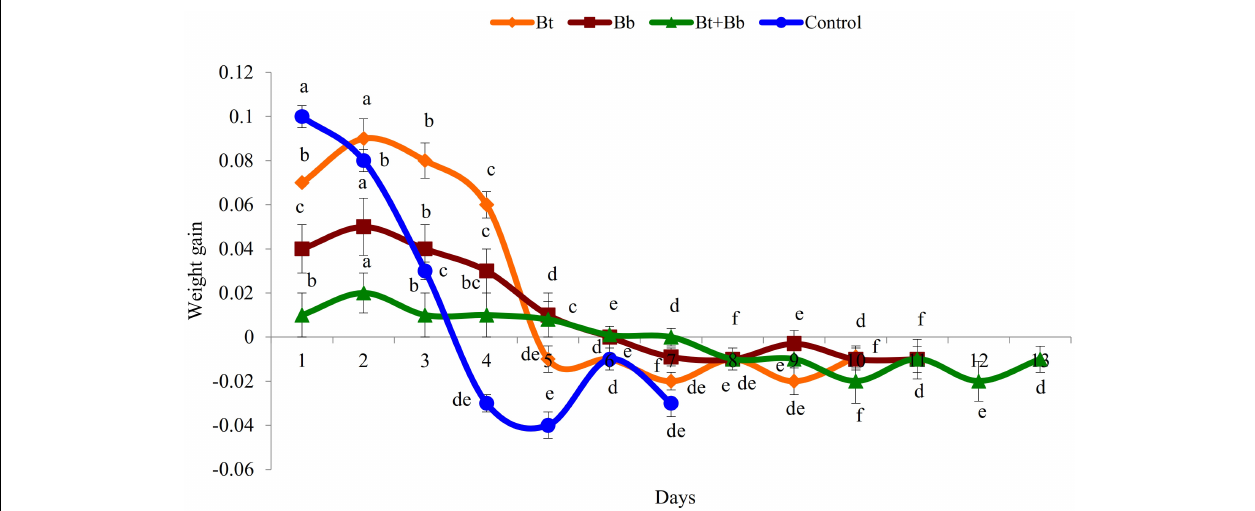
FIGURE 4 | Weight gain (g) in last instar H. armigera treated with endophytic B. bassiana (Bb: 1 × 10 5 conidia ml − 1 ) alone and in combination with B. thuringiensis (Bt1: 0.20 µ g ml − 1 ). Means followed by the same letter within each treatment are not significantly different; HSD test P ≤ 0.05.